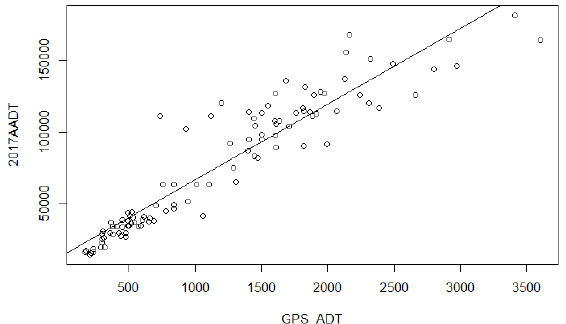
Figure 6. Scatterplot and linear regression line between GPS_ADT and AADT